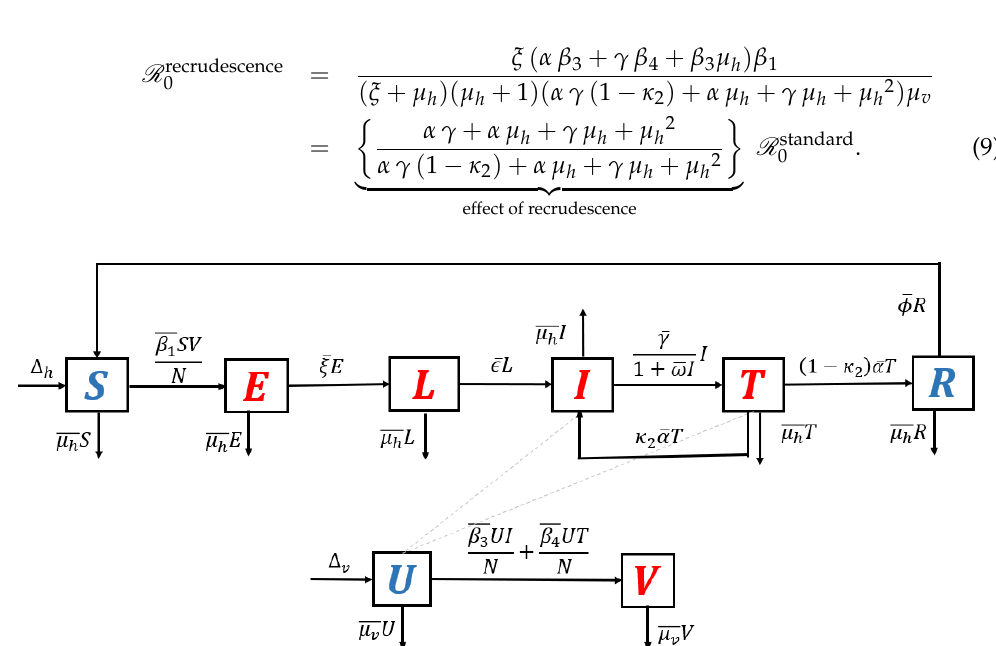
Figure 7. Transmission diagram of malaria disease with recrudescence only, without relapse and